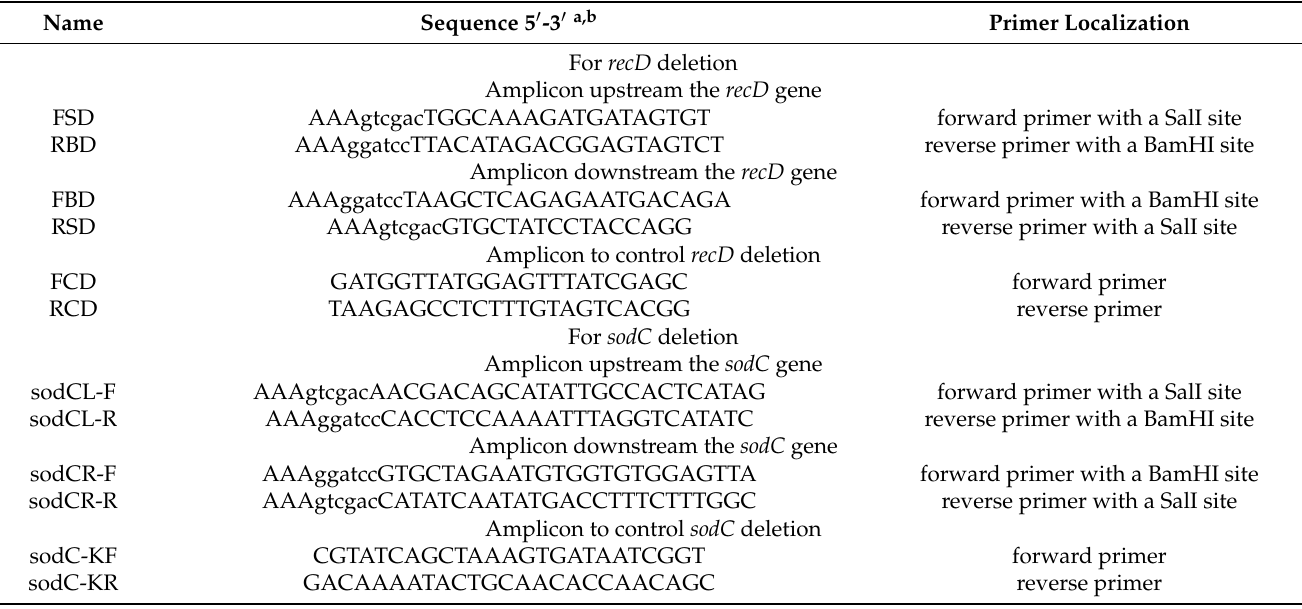
Table 2. Primers used in this